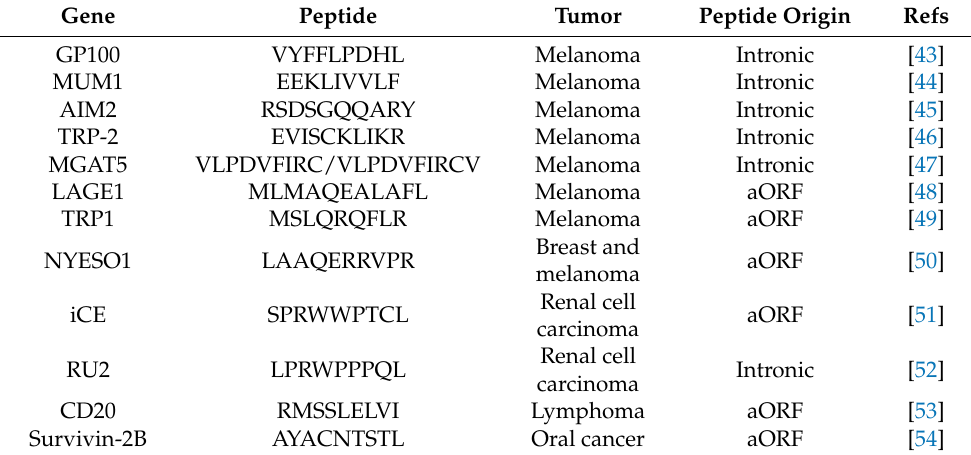
Table 2. Empirically derived immunogenic HLA class I-restricted peptides derived from alternative